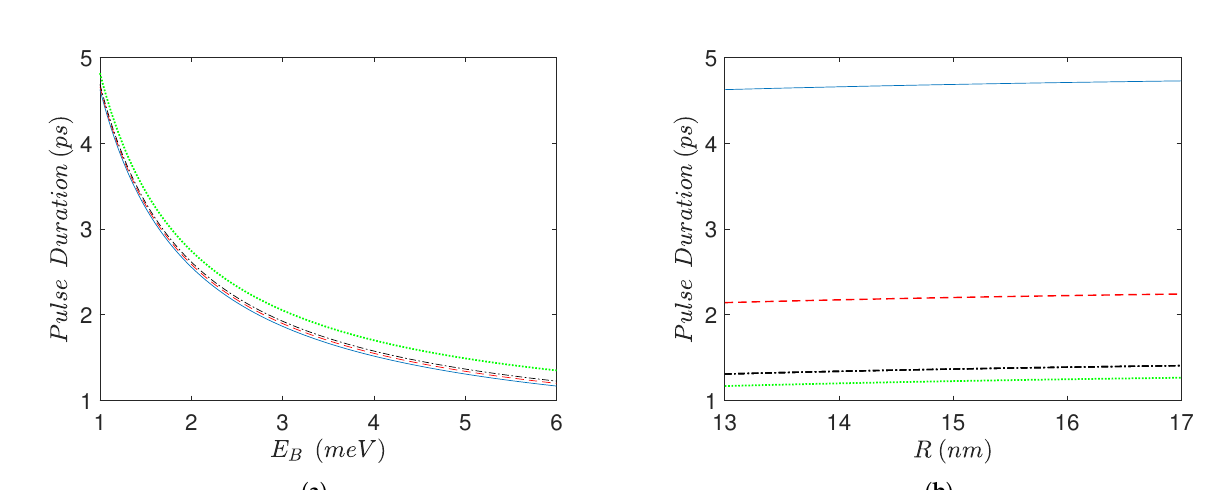
Figure 5. ( a ) Pulse-sequence duration as a function of biexciton energy shift E B , for four values of the interparticle distance, R = 13 nm (blue solid line), R = 14 nm (red dashed line), R = 15 nm (black dashed-dotted line), R = 30 nm (green dotted line). ( b ) Pulse-sequence duration as a function of interparticle distance R , for four values of the biexciton energy shift, E B = 1 meV (blue solid line), E B = 2.5 meV (red dashed line), E B = 5 meV (black dashed-dotted line), E B = 6 meV (green dotted